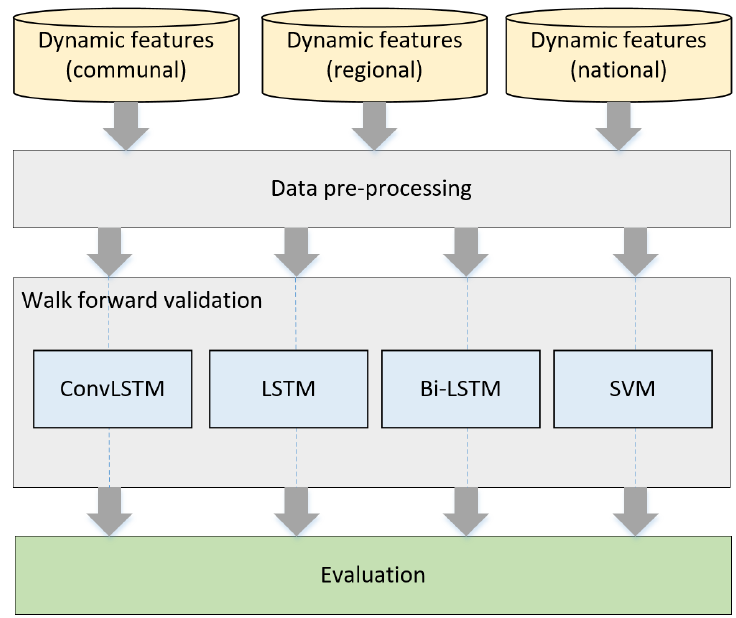
Figure 2. Proposed